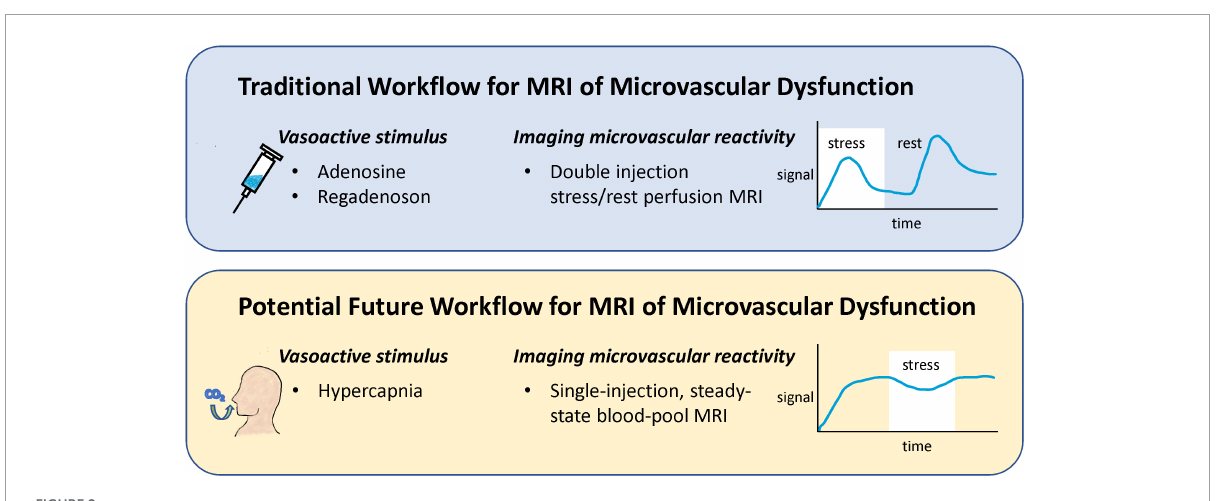
FIGURE2 Comparison of a potential future workflow for MRI of microvascular dysfunction to conventional workflow. Instead of injecting a vasoactive drug to induce vasoreactivity, breathing elevated levels of CO 2 is proposed as a safer, more repeatable vasoactive alternative. Furthermore, traditional assessment of perfusion change in response to stress via a double gadolinium injection protocol is replaced with a single-injection, blood-pool contrast imaging protocol that permits higher accuracy and